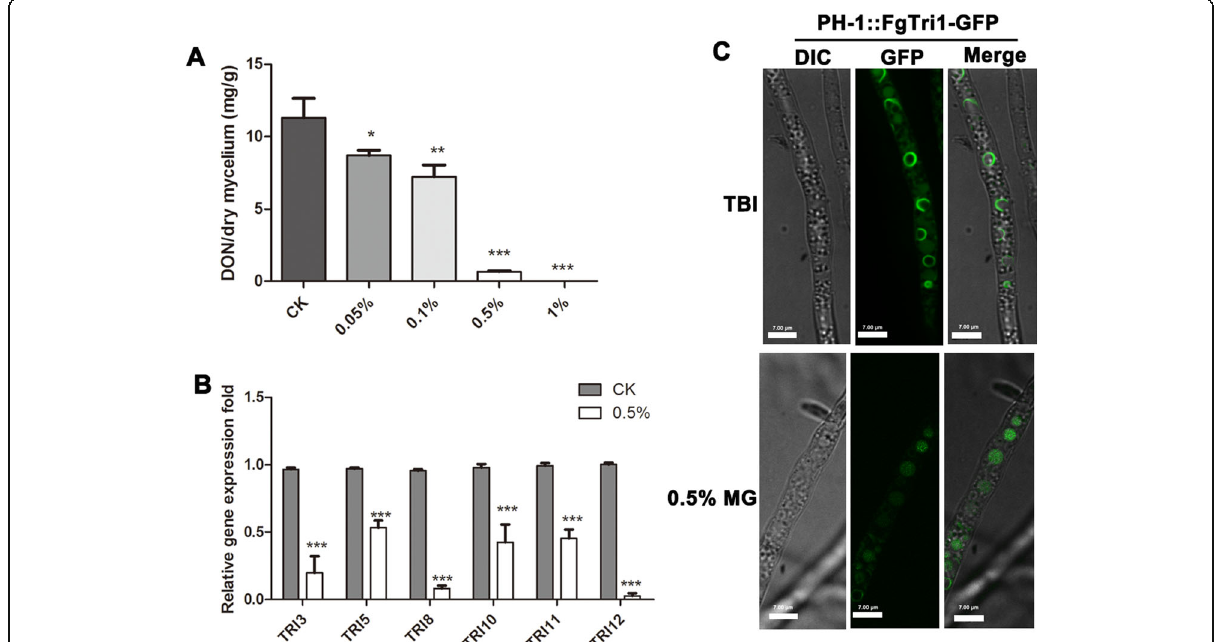
Fig. 3 MG treatment affects DON biosynthesis. A DON production was normalized with the dry mycelium collected from the culture. B Relative expression of TRI genes involved in DON biosynthesis was determined by qRT-PCR. C DON-toxisome was examined in the hyphae harvested from 3 day-old liquid TBI culture with or without 0.5% (w/v) MG treatment under fluorescence confocal microscope. Each treatment has three replicates, * means p < 0.05, ** means p < 0.01 and *** means p < 0.001. Bar = 10 μ